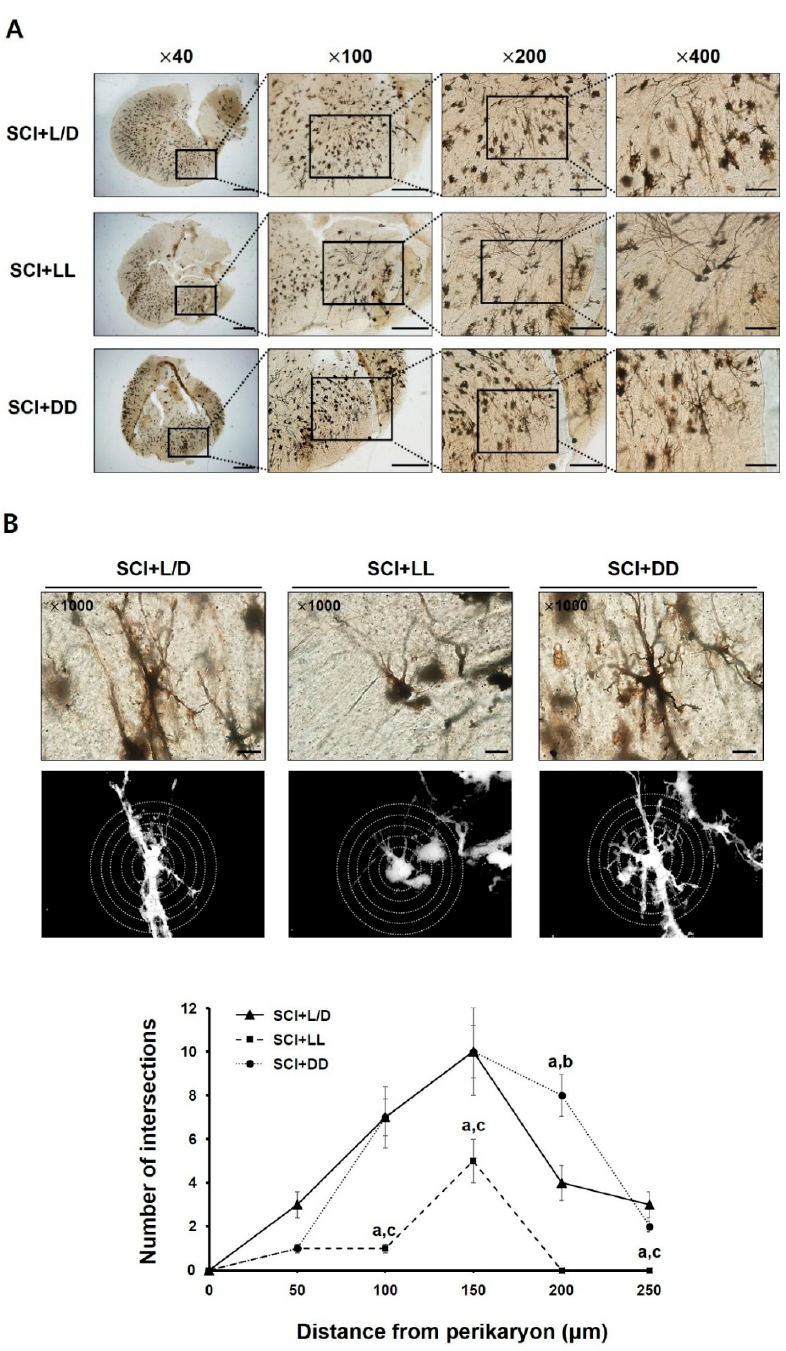
Figure 6. Golgi-cox stained sections of spinal cord from the rats subjected to controlled light/dark cycle. ( A ) Experimental animals were kept in controlled light/dark cycle; L/D, LL, and DD. A total of 3 days after SCI surgery, histological differences in the injured spinal segment were investigated. Magnification = ×4, ×100, ×200, ×400; Scale bar = 500 μ m (×40, ×100), 200 μ m (×200, ×400). ( B ) Neurite outgrowth of the neurons in Golgi-stained spinal sections was quantified using Sholl analysis method. The Sholl rings are separated by 10 μ m. The data were expressed as mean ± SD. L/D, 12/12-h light/dark; LL, 24-h constant light; DD, 24-h constant dark. a p < 0.05 vs. L/D; b p < 0.05 vs. LL; Magnification = ×1000; Scale bar = 100 μ m.